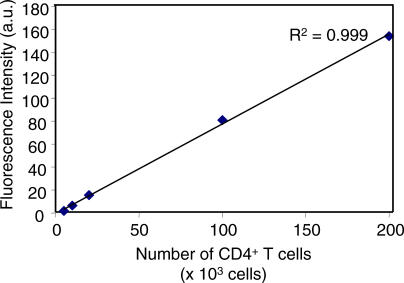
CD4 Lymphocyte Dose ResponsePurified CD4 cells were labeled with AlexaFluor-488-conjugated anti-CD4 antibodies, introduced to the flow cell in amounts ranging from zero to 200,000 cells and imaged. There is a linear correlation between the number of cells in the sample and the intensity of light emitted from the membrane filter (R
2 = 0.999).